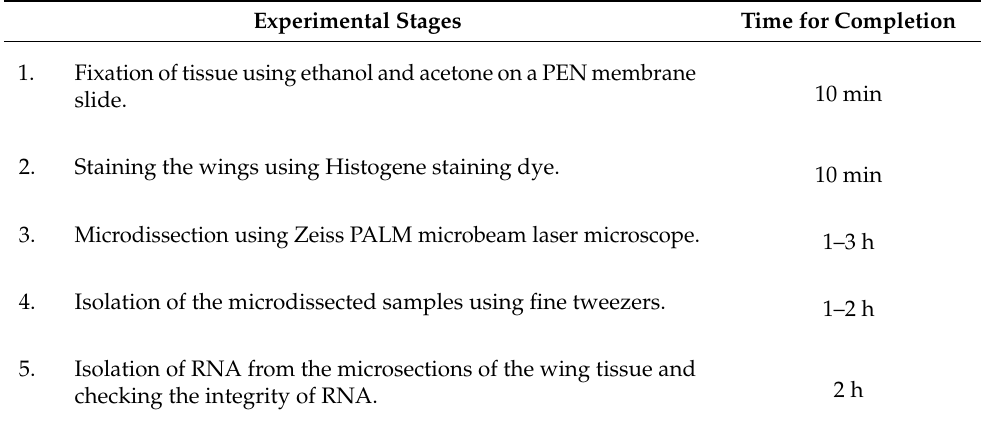
Table 1. Experimental stages and time needed to complete each stage. Experimental